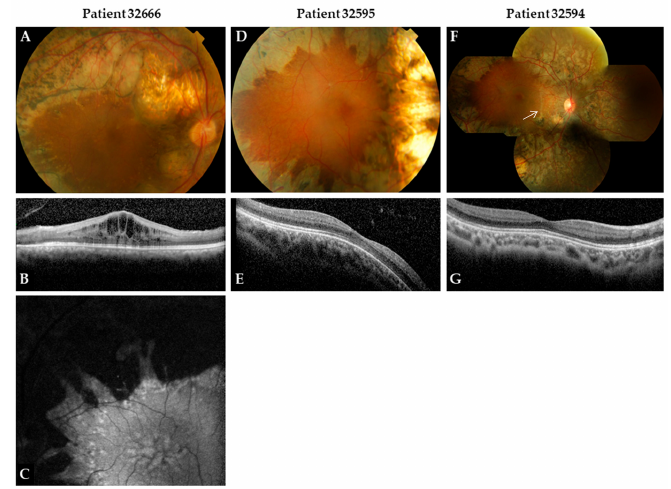
Figure 1. Fundus photographs and optical coherence tomography (OCT) of the right eye of patient 32666 at age 29, patient 32595 at age 8 and patient 32594 at age 7. Fundus autofluorescence (FAF) of the left eye of patient 32666 at age 29. All fundus images ( A , D , F ) show a pink optic disk, relatively normal arterioles ( D , F ) or slightly attenuated arterioles ( A ). All show midperipheral pronounced retinal pigment epithelium (RPE) atrophy with nummular pigmentations, and a preserved macular region. Subtle yellow dots are visible along the border of atrophic and preserved RPE. A vertical line was observed in patient 32594 (( F ), arrow), suggesting subretinal fibrosis. OCT images show cystoid maculopathy with intact ellipsoid zone (EZ) ( B ), and a normal architecture of the retinal layers ( E , G ). FAF image of the left eye of patient 32666 ( C ) shows pronounced hypoautofluorescence outside the vascular arcade with central hyperfluorescent spots, and spoke-like relative increased autofluorescence in the